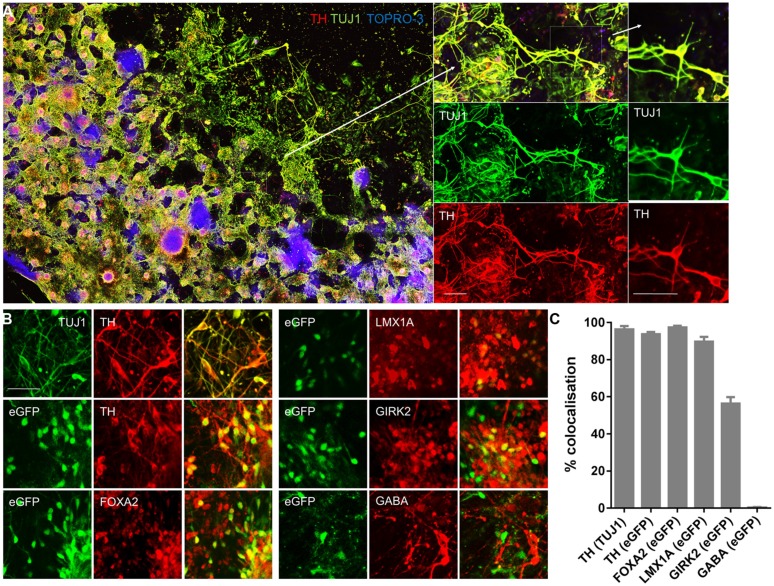
PITX3eGFP/w cells express protein markers of midbrain dopaminergic neurons. Immunocytochemical analysis of PITX3eGFP/w cultures was performed at day 20 in order to confirm the presence of an mDA neuronal phenotype. (A) Wells were replete with the neuronal marker β-III tubulin (TUJ1; green), which was almost always co-localized with the dopaminergic marker tyrosine hydroxylase (TH; red). The panels, from left to right, show low and high powered color-merges of TUJ1 and TH, in combination with the nuclear stain TO-PRO-3 (blue). (B) Immunocytochemical analysis of PITX3eGFP/w cultures was performed at day 20 in order to confirm the presence of an mDA neuronal phenotype. Populations of PITX3eGFP/w cells expressed mDA markers TH, FOXA2, LMX1A, and the A9 group marker GIRK2, but not the GABAergic marker GABA. (C) Shows the relative co-localization of protein markers at day 20. The columns represent the percentage of cells positive for both markers (data presented as mean ± SEM, n = 3 fields of view from independent wells). Scale bars; 100 μm.